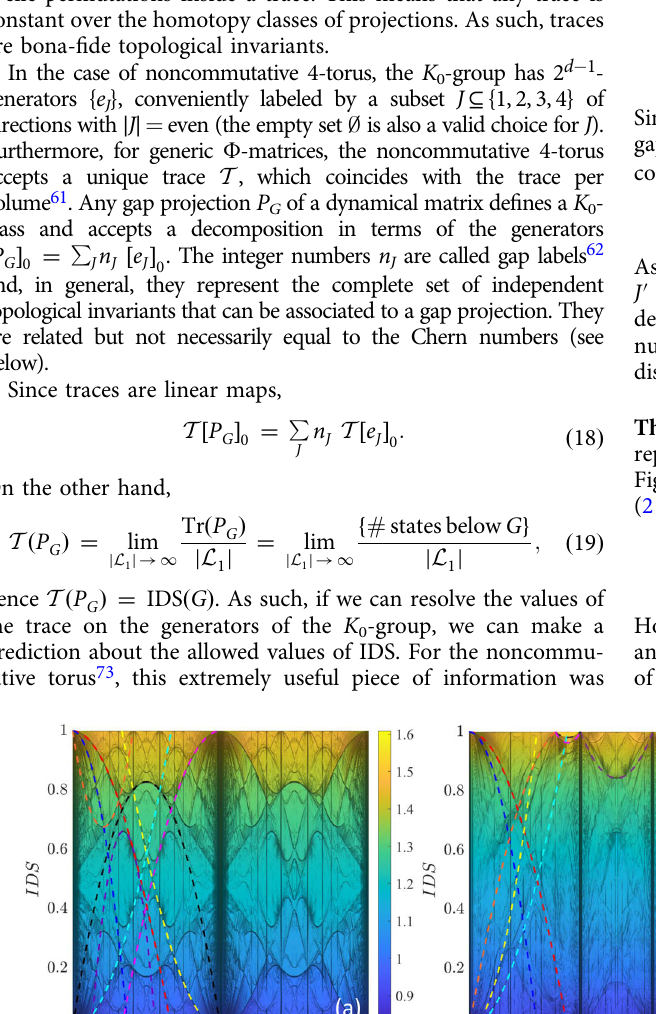
ffiffiffi ffiffiffi p p = a = 1 and β ¼ π = , a 2 = 1 and β ¼ π = 7 , and ( c ) a 1 ¼ 1 = 2 ½ 4 (cid:3) 1 2